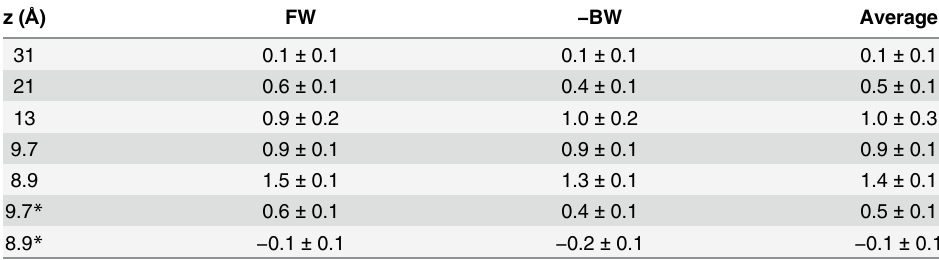
Table 1. Na + /K + selectivity free energies at various ion positions. The ΔΔ G sel (Na + ! K + ) values are obtained from FEP calculations using Eq 1 (in units of kcal/mol). FW and BW refer to the forward and back- ward FEP calculations, respectively. The final result in the last column is obtained from the average of the FW and − BW. Star in the last two rows indicate that the FEP calculations are performed for the K1237A analog of the